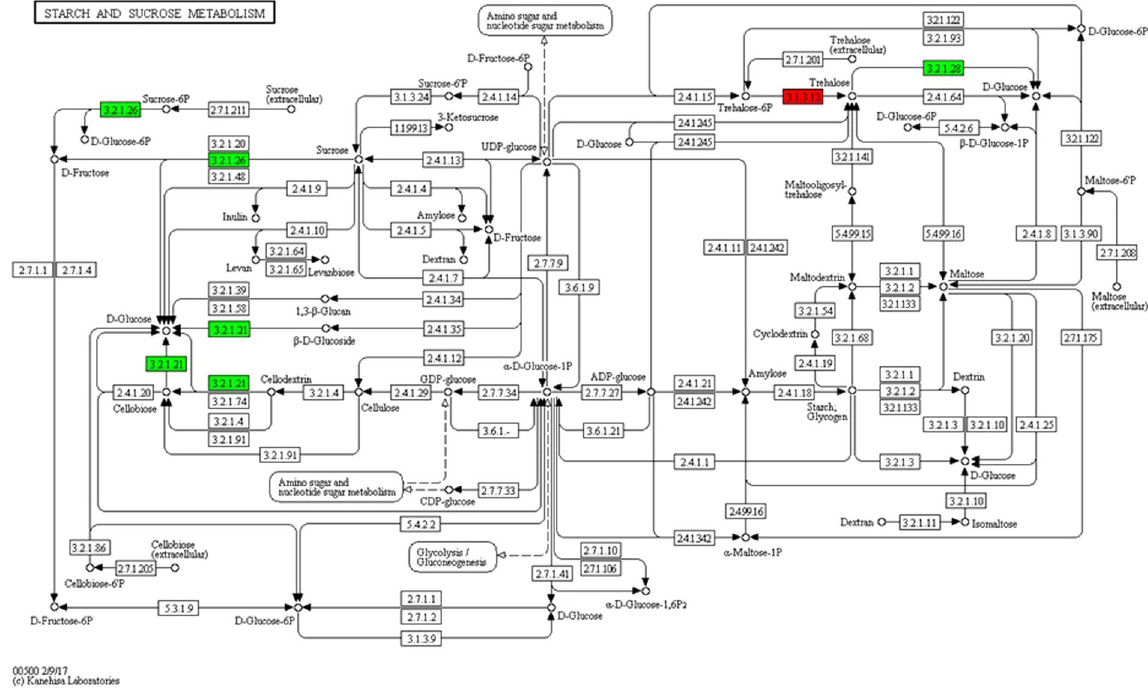
Figure 4. KEGG enrichment analysis of starch and sucrose pathway in stem xylem tissue of Valsa -infected poplar. KEGG pathway map for starch and sucrose pathway (ko00500). Red indicates activity of the enzyme is induced by canker pathogen, while green indicates activity of the enzyme is inhibited.